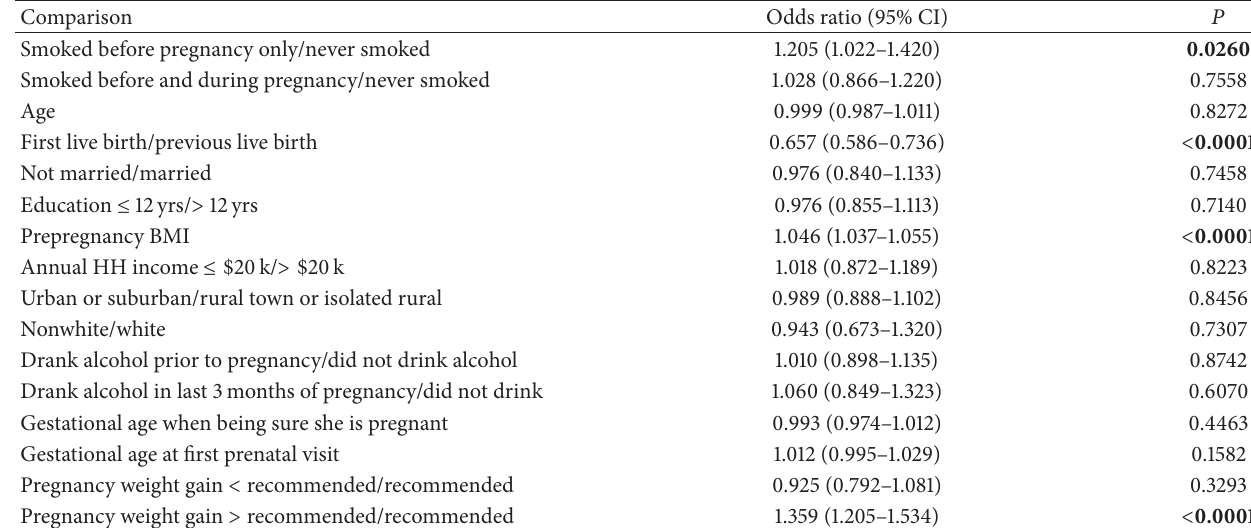
Table 6: Maternal predictors of hypertension during